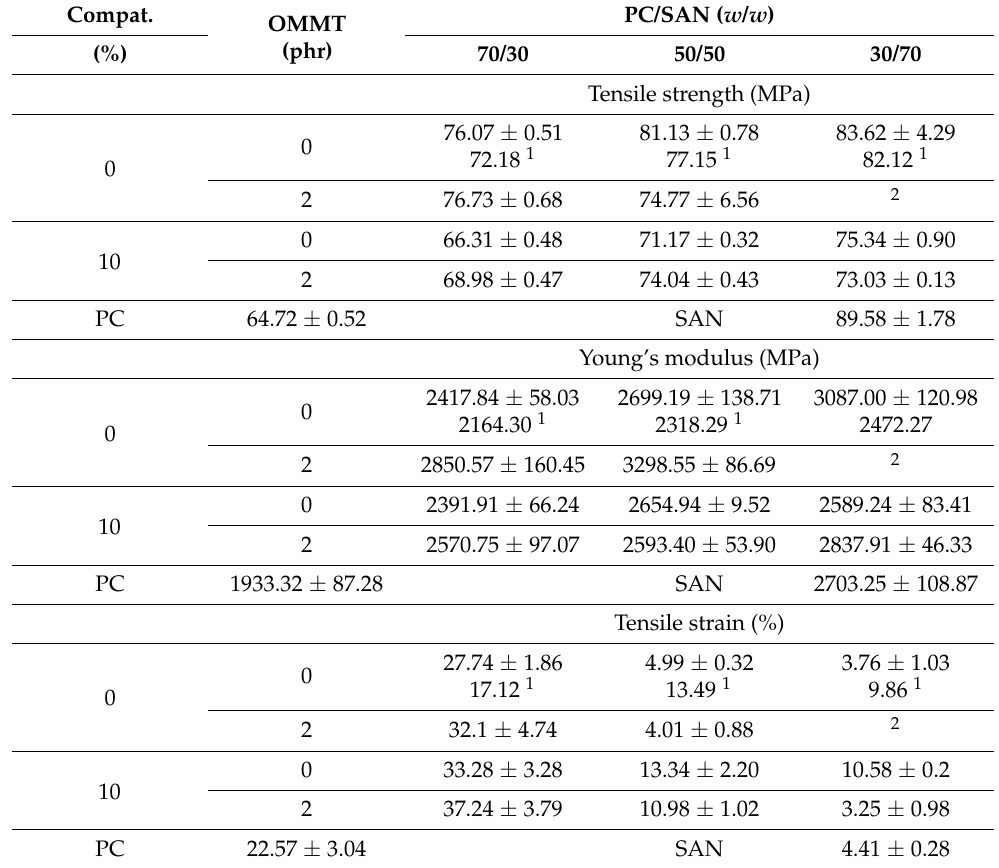
Table 6. Tensile properties of non-compatibilized and compatibilized (with ABS-g-MAH) PC/SAN blends and their nanocomposites.